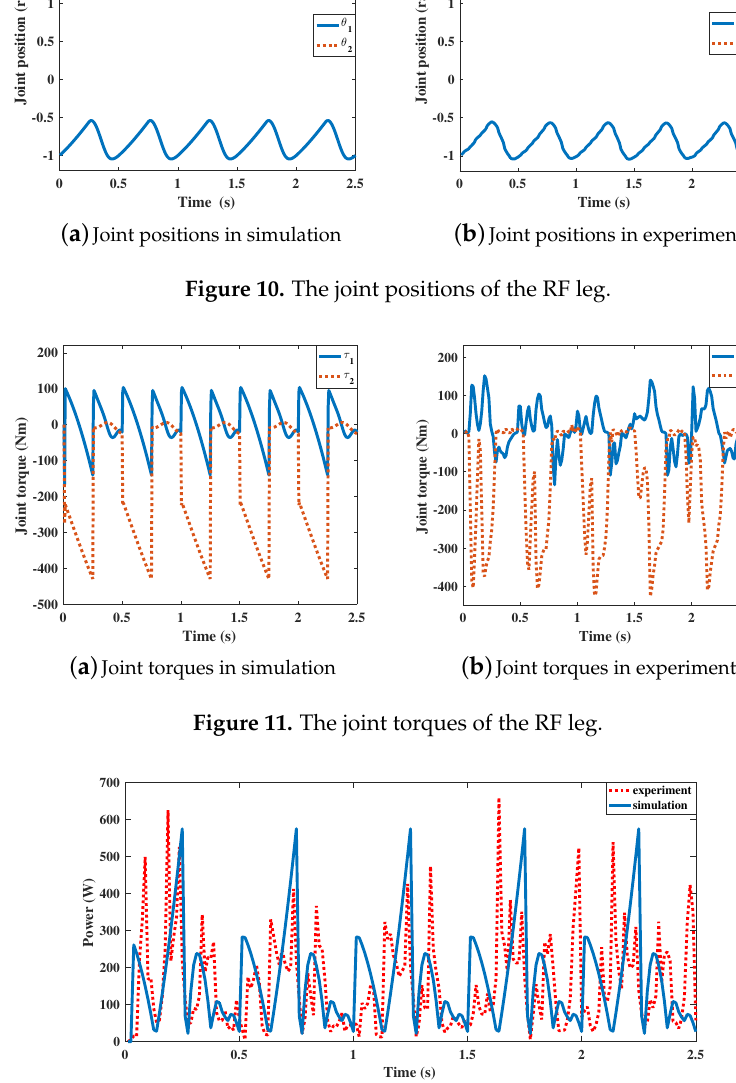
Figure 12. A comparison of the power variation between the experiment and